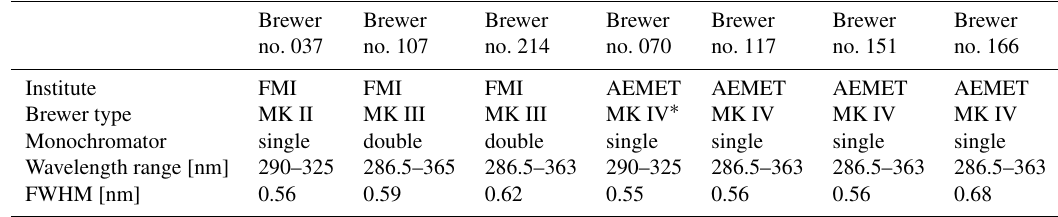
Table 1. The Brewers used in the study and their characteristics.